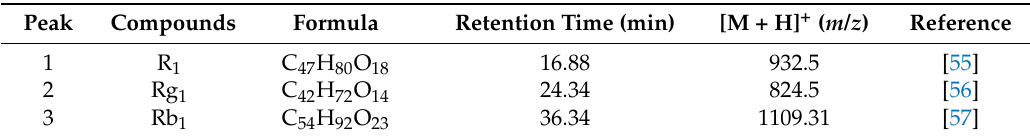
Table 5. The detected chromatographic and spectrometric data of the separated compound in the HPLC